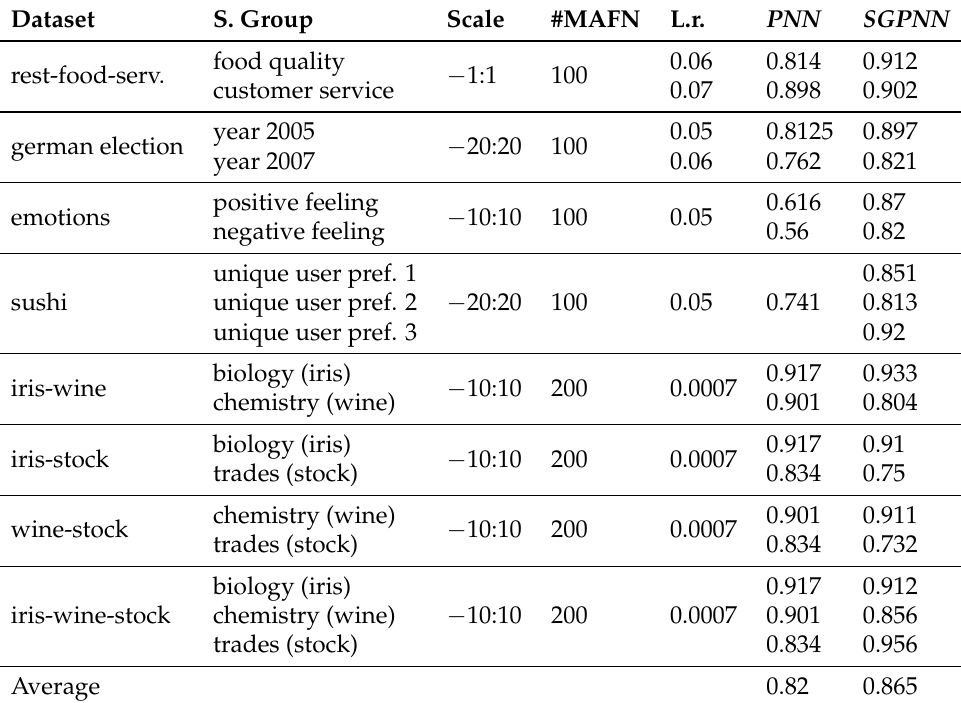
Figure 9. Training convergence of PNN and SGPNN using ( a ) german election 2005 and 2009 dataset. ( b ) iris,wine and stock dataset. Table 4. Performance comparison of SGPNN and PNN on conjoint and other dataset.